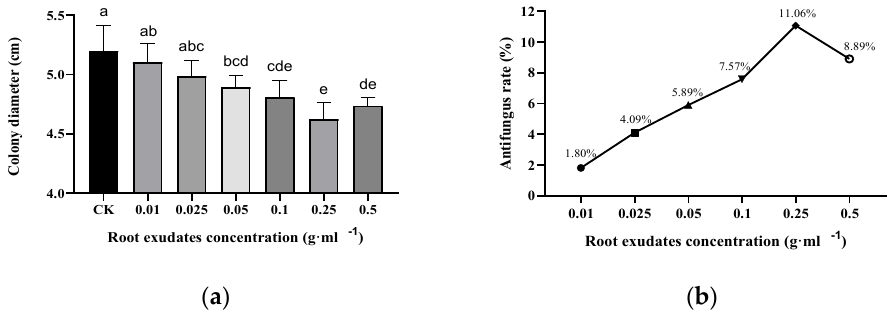
Figure 2. Effect of peanut root exudates on Fusarium solani growth, ( a ) colony diameter of Fusarium solani after peanut root exudates treating, ( b ) inhibition rate of peanut root exudates in petri dish experiments. The different letters represent significant differences at p < 0.05 (Tukey’s test).